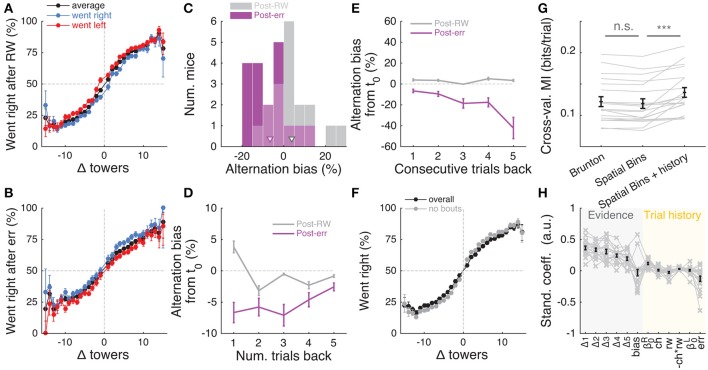
Choice is moderately influenced by previous trial history. (A) Psychometric curves for aggregate data (metamouse) divided according to previous choice in rewarded trials. Black: average post-reward curve, blue: psychometric curve for trials following rewarded right choices, red: psychometric curve for trials following rewarded left choices. Error bars: binomial confidence intervals. (B) Psychometric curves divided according to previous choice in error trials. Conventions as in (A). (C) Distribution of alternation bias after reward (gray) or error (magenta) trials. Arrowheads: population mean. (D) Magnitude of alternation bias calculated for 1–5 trials after a choice, separately for rewarded and unrewarded trials. Error bars: ± SEM across mice (n = 18 with at least 1,000 trials after removing trials with fewer than 5 history trials). (E) Magnitude of alternation bias calculated for 1–5 trials after identical rewarded or unrewarded choices. Error bars: ± SEM. (F) Psychometric curves for aggregate data (metamouse) with the trial selection adopted throughout the paper (black) and adopting an additional criterion to exclude at least 3 consecutive-choice trials (gray). Error bars: binomial confidence intervals. (G) Comparison of cross-validated model prediction performance for the Brunton et al. DDM, the spatial-bin logistic regression, and the latter plus trial history terms. Thin gray lines: individual mice, black lines and error bars: mean ± SEM. ***P < 0.001. MI: model information index. (H) Best-fit standardized coefficients for the spatial bins model with trial history terms. Thin gray lines: individual mice, thick black lines: population mean, error bars: ± SEM.